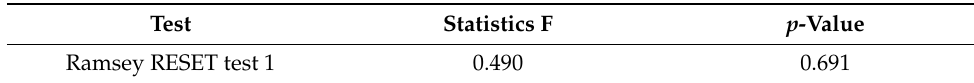
Table A7. The specification test results of the first model.